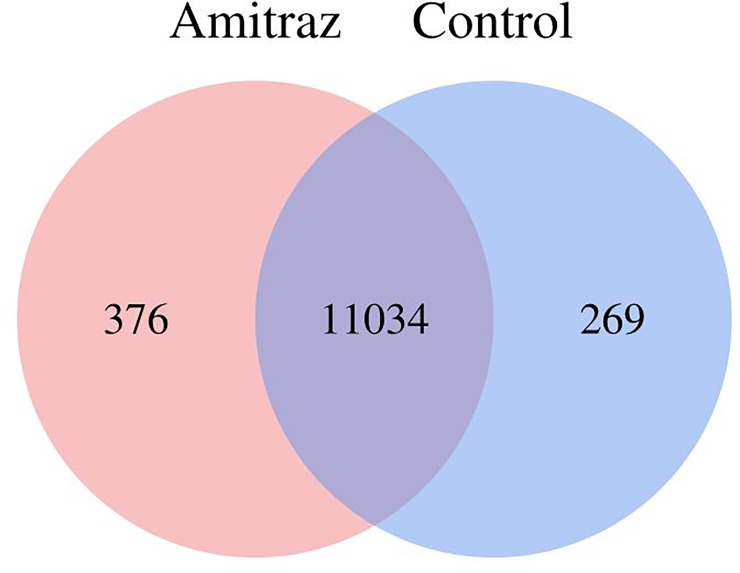
Average number of genes specifically expressed in amitraz and control libraries.Shown as the number of genes expressed in each class.